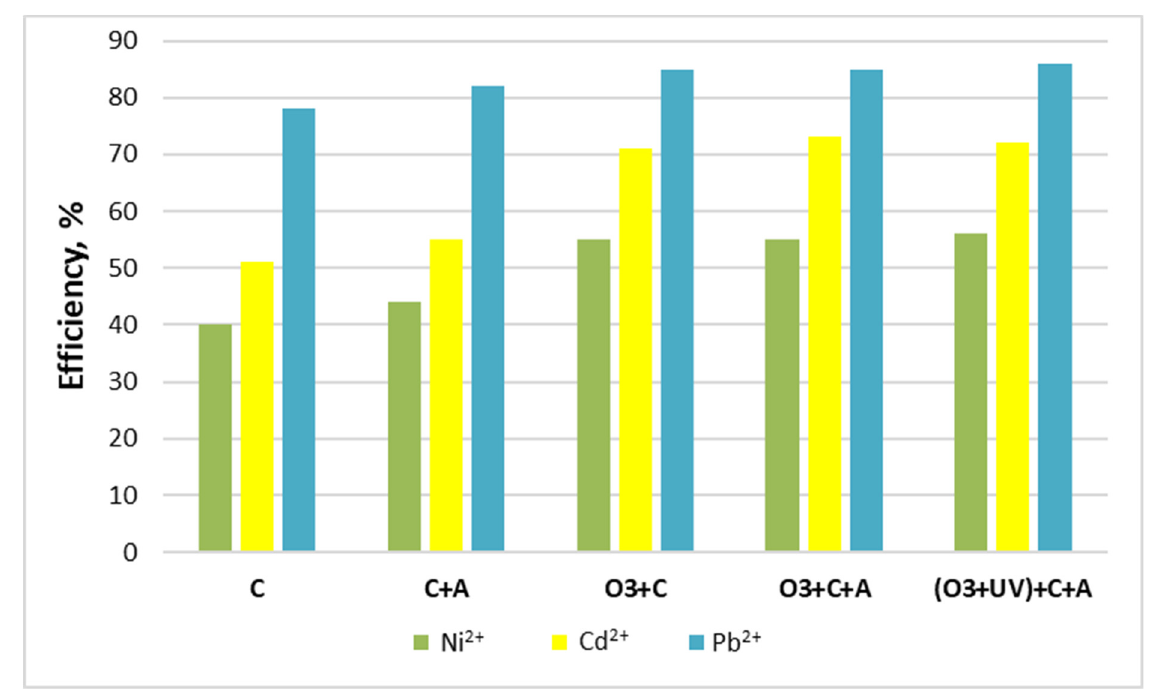
Figure 5. Efficiency of tested metal ions removal from modified surface water treated in the coagulation process and hybrid processes; C—coagulation; C + A—coagulation + adsorption; O 3 + C—ozonation + coagulation; O 3 + C + A—ozonation + coagulation + adsorption; (O 3 + UV) + C + A—ozonation + UV 254 irradiation + coagulation + adsorption; PAC